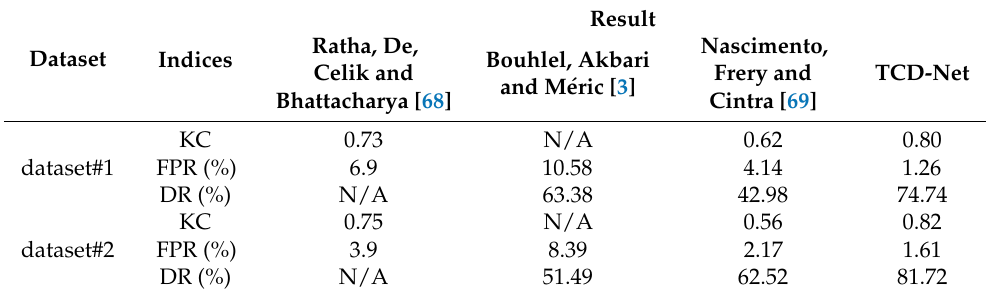
Table 8. Comparison of TCD-Net results with other methods developed on UAVSAR images.